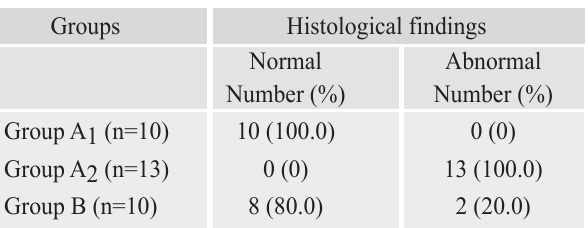
Table IIIA: Distribution of rats by histological changes in liver (n=33)